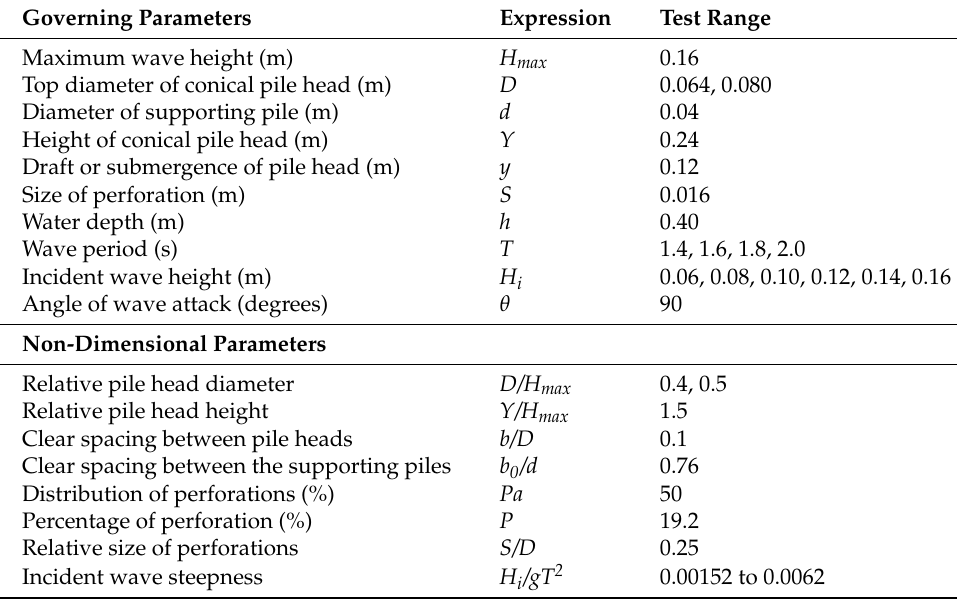
Table 1. Structural and wave parameters of the experimental